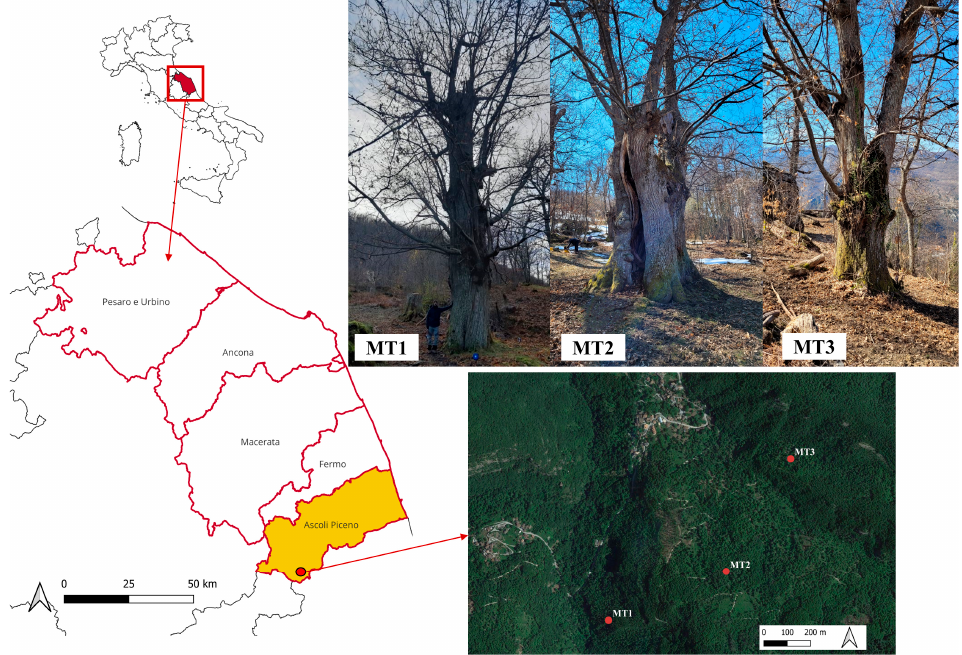
Figure 1. Study area location and a view of the three monumental chestnut trees in the winter season. Traditional chestnut orchards usually have a low tree density to favor fruit production, and the target trees were selected both for their architecture and accessibility. These monumental trees are located at a suitable distance from other trees, making the